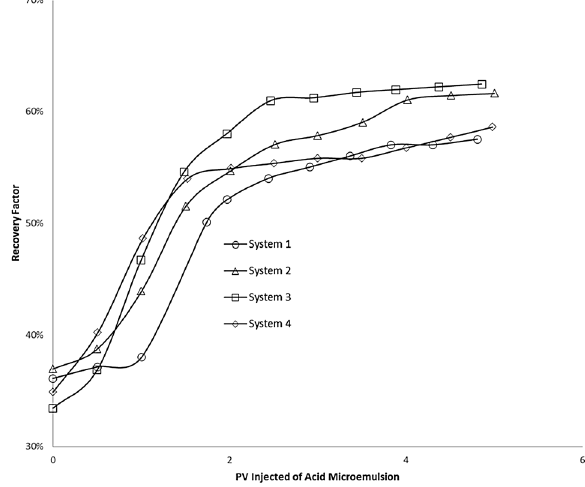
Fig. 7 Curves of recovery factor as a function of PV injected of